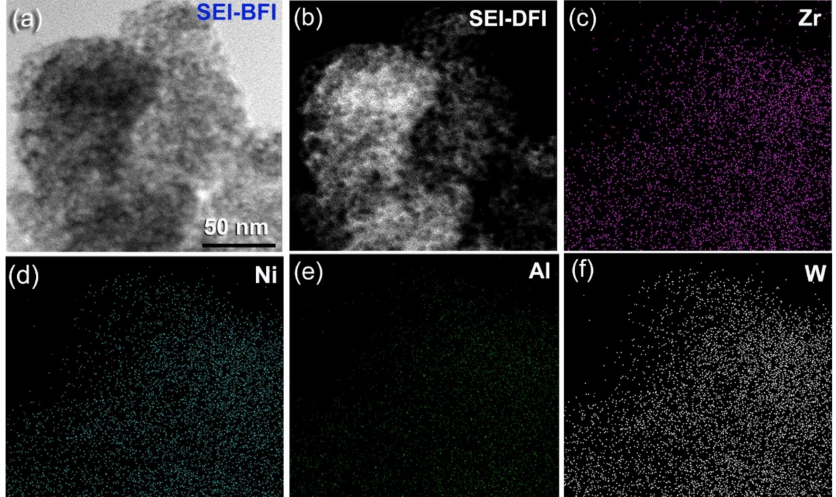
Figure 6. Local elemental analysis and structural characteristics of (Zr 75 Ni 25 Al 5 ) 65 W 35 powders obtained after 100 passes of CR and then HEBM for 100 h; ( a ) scanning transmission-bright field image (SEI-BF), ( b ) scanning transmission-dark field image (SEI-DF), and the corresponding EDS elemental mapping of ( c ) Zr, ( d ) Ni, ( e ) Al, and ( f )